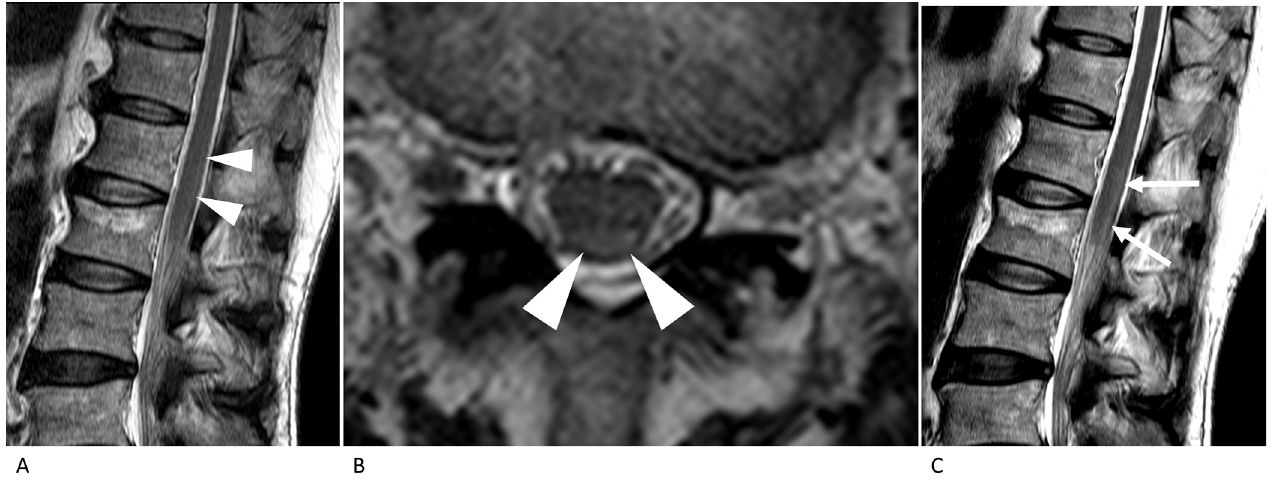
Fig 2. T2-weighted MRI of the thoracolumbar spine in the patient with spinal cord infarction (76-year-old man, patient number 1 in Table 4). On the sagittal (A) and axial (B) images obtained between 12 and 24 h after symptom onset, mild hyperintensity is suspected at the dorsal spinal cord